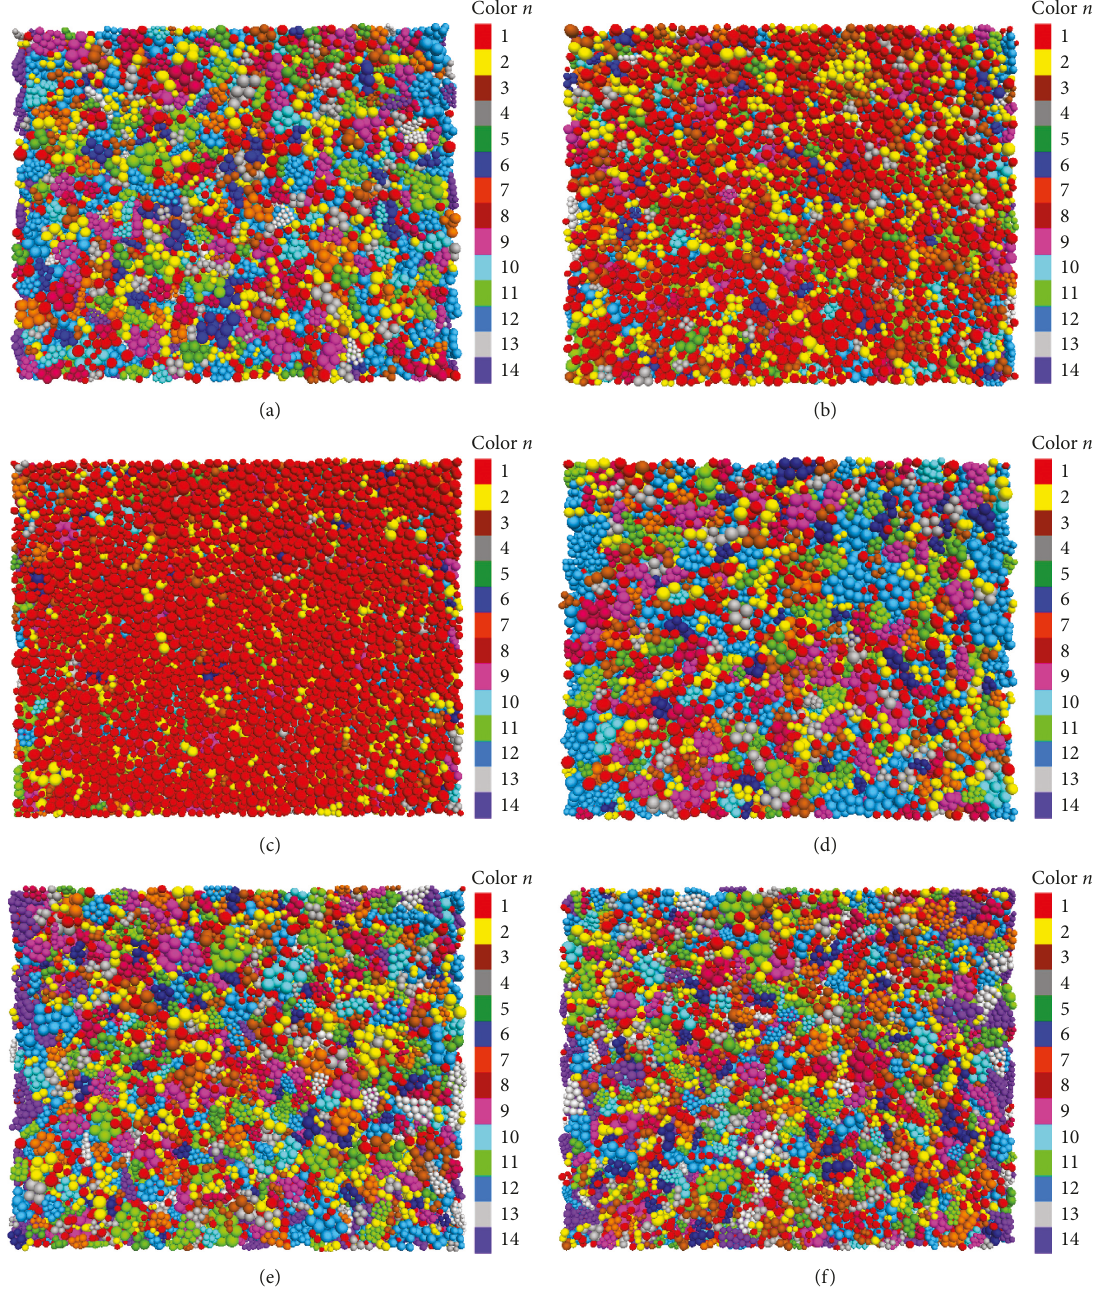
Figure 15: Schematic view of number of spheres that particles have on the interface in the final state: (a) SY_2_15; (b) SY_4_15; (c) SY_7_15; (d) SY_2_0; (e) SY_2_37.5; (f) SY_2_60. n , the number of spheres one particle